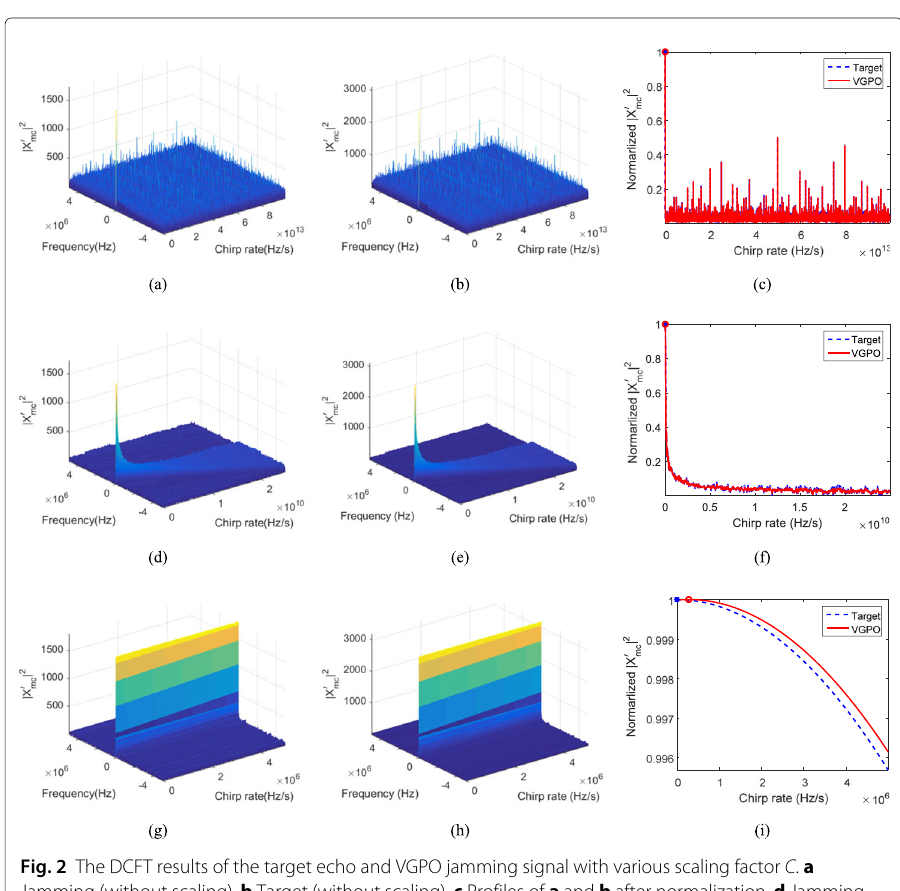
Fig. 2 The DCFT results of the target echo and VGPO jamming signal with various scaling factor C . a Jamming (without scaling). b Target (without scaling). c Profiles of a and b after normalization. d Jamming ( C = 4e3). e Target ( C = 4e3). f Profiles of a and b after normalization. g Jamming ( C = 2e7). h Target ( C = 2e7). i Profiles of g and h after